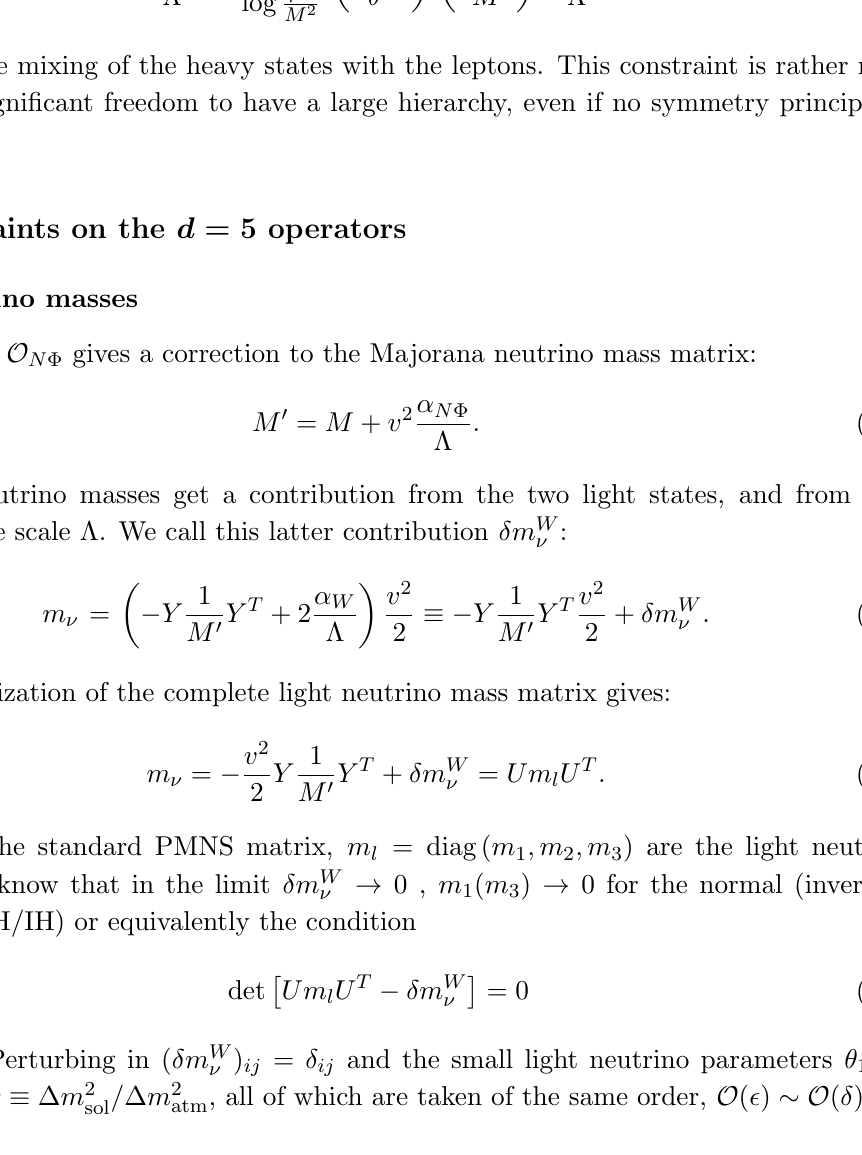
to the neutrino O N (cid:8)